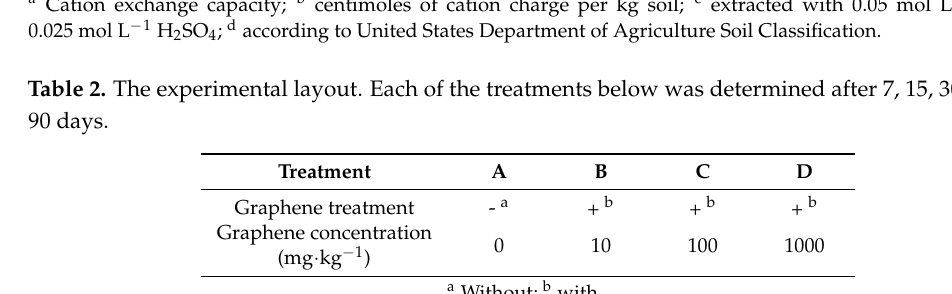
Table 1. Selected properties of A 1 horizon soil at the initiation of the experiment (mean, n = 3). Organic Hydrolytic N Available P Available K Soil pH CEC a Parameter (mg kg − 1 ) Texture Matter (%) (mg kg − 1 ) (mg kg − 1 ) c (KCl) (cmol kg − 1 ) b Measurement 4.02 a Cation exchange capacity; b centimoles of cation charge per kg soil; c extracted with 0.05 mol L − 1 HCl–